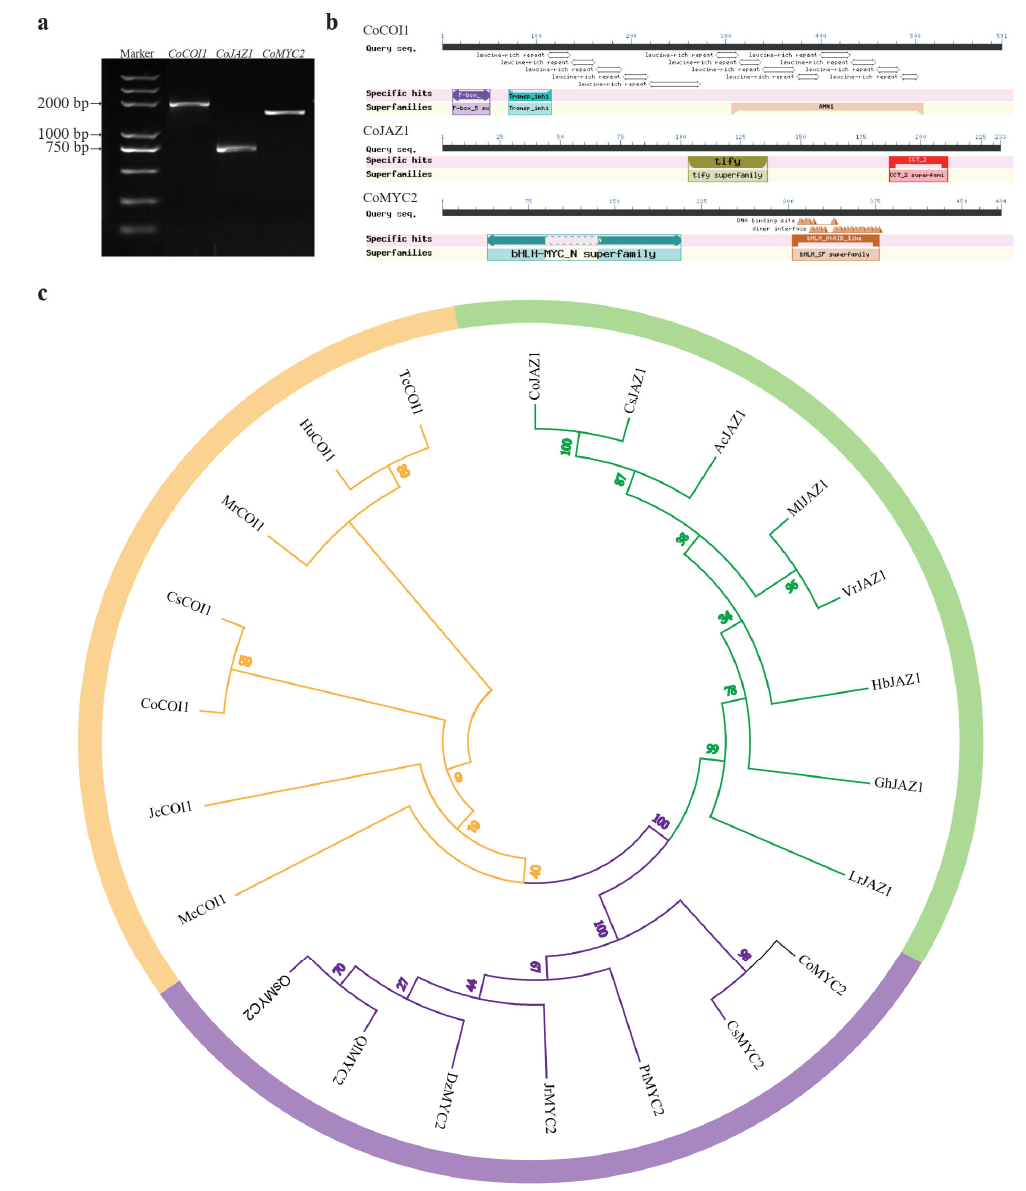
Figure 2. Cloning and bioinformatics analysis of CoCOI1/CoJAZ1/CoMYC2. ( a ) Agarose gel electrophoresis of full-length CDS sequences of CoCOI1/CoJAZ1/CoMYC2 . ( b ) Domain analysis of CoCOI1/CoJAZ1/CoMYC2. ( c ) Phylogenetic tree of CoCOI1/CoJAZ1/CoMYC2.